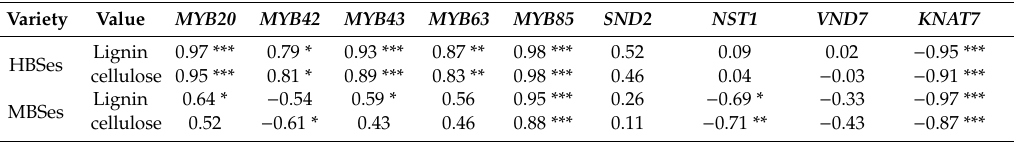
Figure 4. Enzyme activity of two varieties of bamboo shoots at room temperature. ( A ) Changes in the PAL activity in HBSes. ( B ) Changes in the PAL activity in MBSes. ( C ) Changes in the POD activity in HBSes. ( D ) Changes in the POD activity in MBSes. Error bars indicate the standard error. Di ff erent letters indicate significant di ff erences ( p < 0.05) among various storage times in HBSes (lowercase letters) and MBSes (uppercase letters). Table 2. Correlation analysis between transcription factors and lignin and cellulose contents in high bamboo shoots (HBSes) and moso bamboo shoots (MBSes) under room temperature